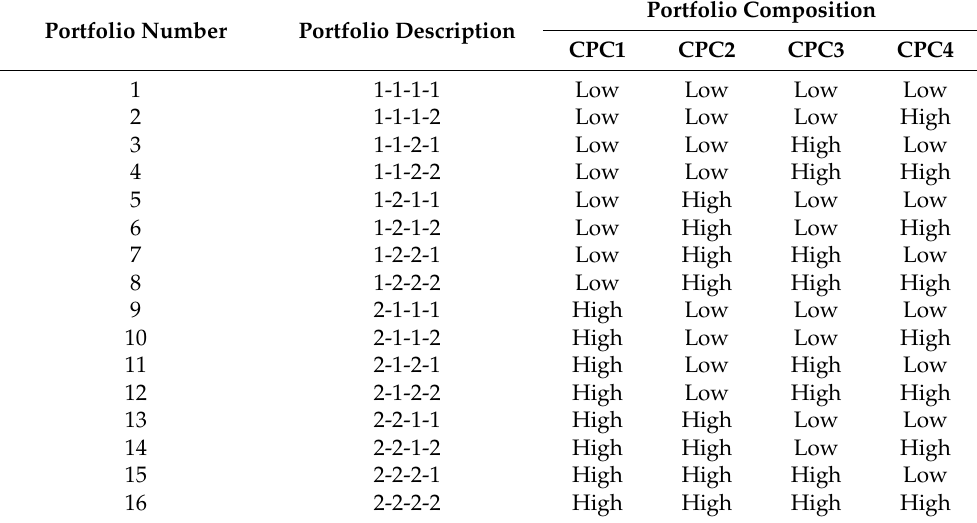
Table 4. Description of